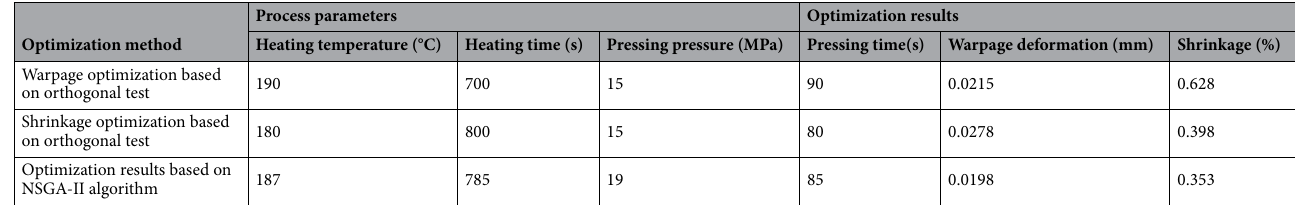
Table 9. Comparison of optimization results of NSGA-II